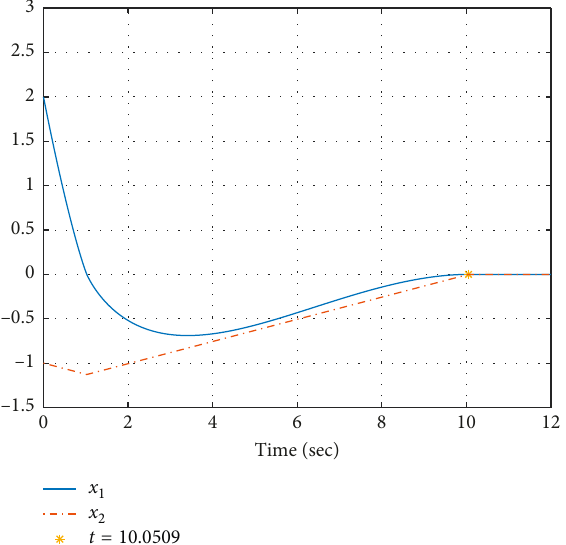
Figure 8: Finite-time convergence with the zero initial condition of the state ( A � ( −